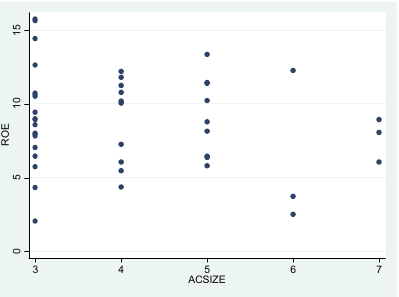
Fig. 4. The results of Pearson correlation between committee size and return on equities of Jordanian